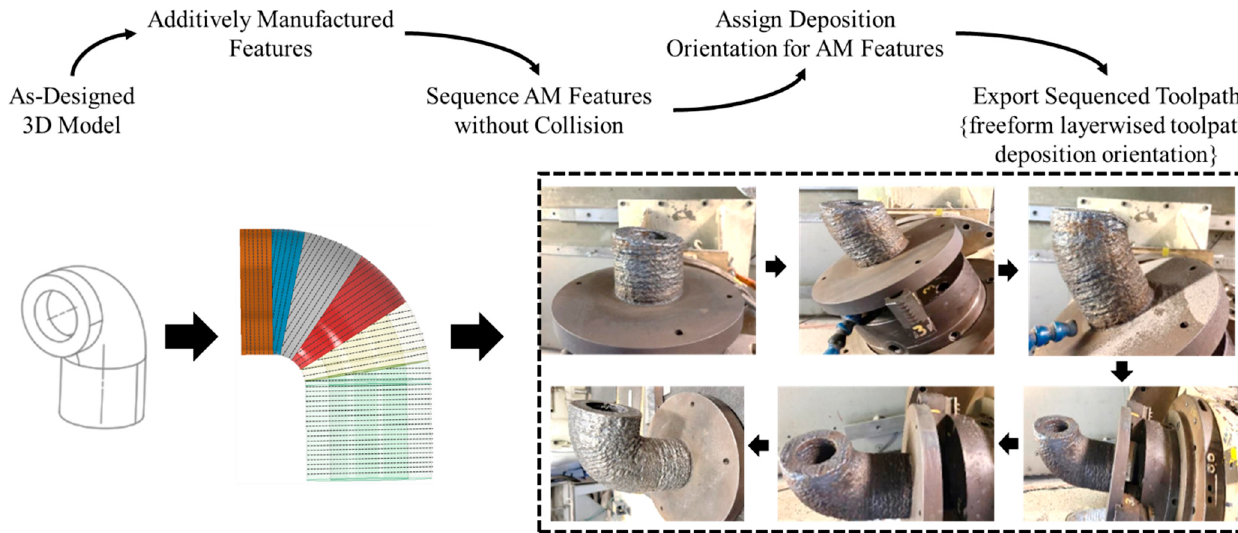
Figure 1. Overall workflow of robotic additive manufacturing.